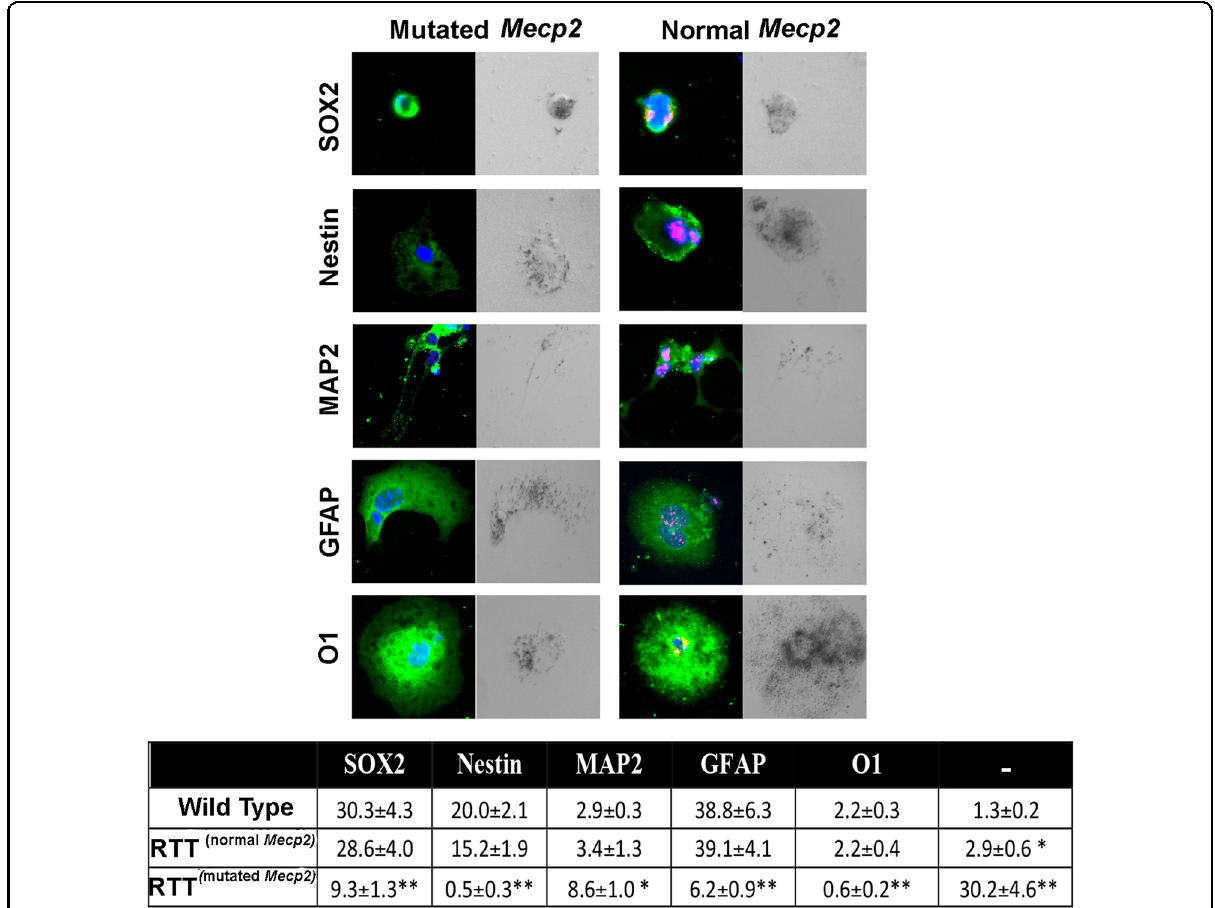
Fig. 5 NSC differentiation and senescence in cells expressing wild-type and mutated Mecp2 . Cells expressing mutated or wild-type Mecp2 were identi fi ed by using the anti-MECP2 primary antibody. In Mecp2 + / − samples, the MECP2 protein (red) was present in cells expressing the wild- type allele and was undetectable in those expressing the mutated allele. The picture shows representative photomicrographs of Mecp2 + / − and control NSCs differentiated for 3 days onto poly- L -ornithine-coated plates in medium without growth factors. The cells were stained in green for SOX2, Nestin, MAP2, GFAP, and O1. The nuclei were counterstained with DAPI (blue). Every microscopic fi eld was also analyzed under a bright-light fi eld to detect senescent-associated β -galactosidase. The senescent cells show a dark gray staining. In the table are indicated the percentages of stem cells (SOX2 + ), early progenitors (Nestin + ), neurons (MAP2 + ), astrocytes (GFAP + ), and oligodendrocytes (O1 + ); the ( − ) symbol indicates the cells that were negative for all the analyzed markers. In the Mecp2 + / − samples, indicated as RTT, the percentage of progenitors and differentiated cells was evaluated in cells expressing either the normal or the mutated allele ( n = 5 biological replicates; * p < 0.05, ** p < 0.01 with respect to samples